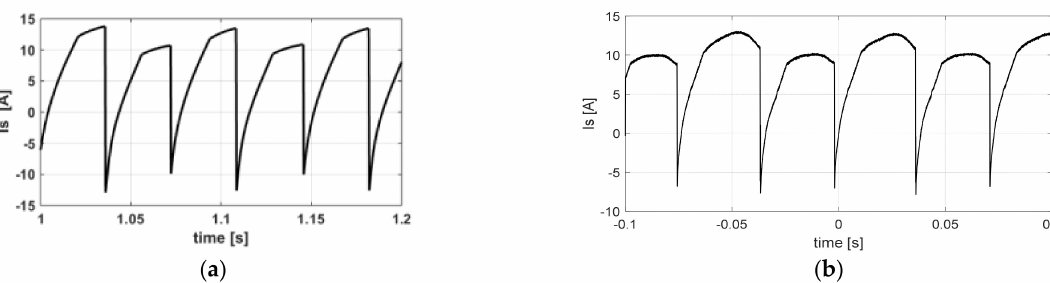
Figure 18. The waveforms of the supply DC current (Is) for no-load at 36 V supply: ( a ) simulation results; ( b ) test